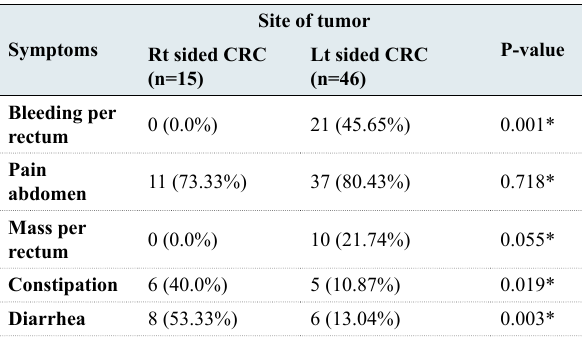
Table 3: Clinical features as per the tumor location in CRC in the study population